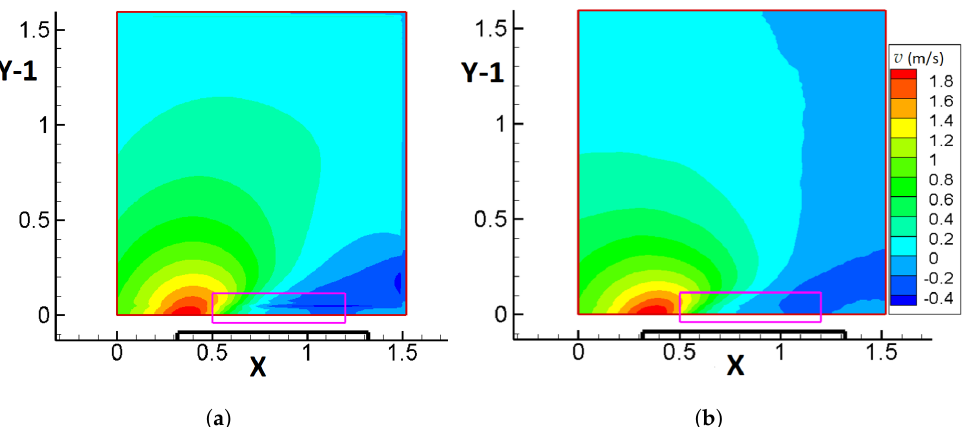
Figure 9. Contours of the v (m/s) velocity component on plane B, extracted by: ( a ) CFD methodology ( v CFD ), ( b ) PIV experimental technique ( v PIV ). The solid boundary of the cube is denoted by the thick black line, while X and Y are non-dimensional coordinates (non-dimensional distance of 1 corresponds to 1 cube height). The pink box denotes the area for Figure 10. Flow is from left to right.